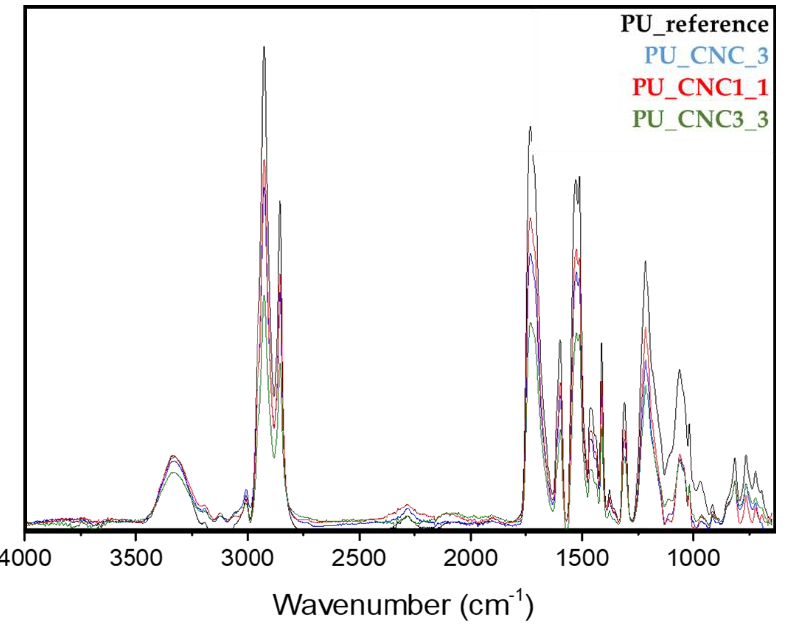
Figure 5. FTIR spectra for selected polyurethane foams .